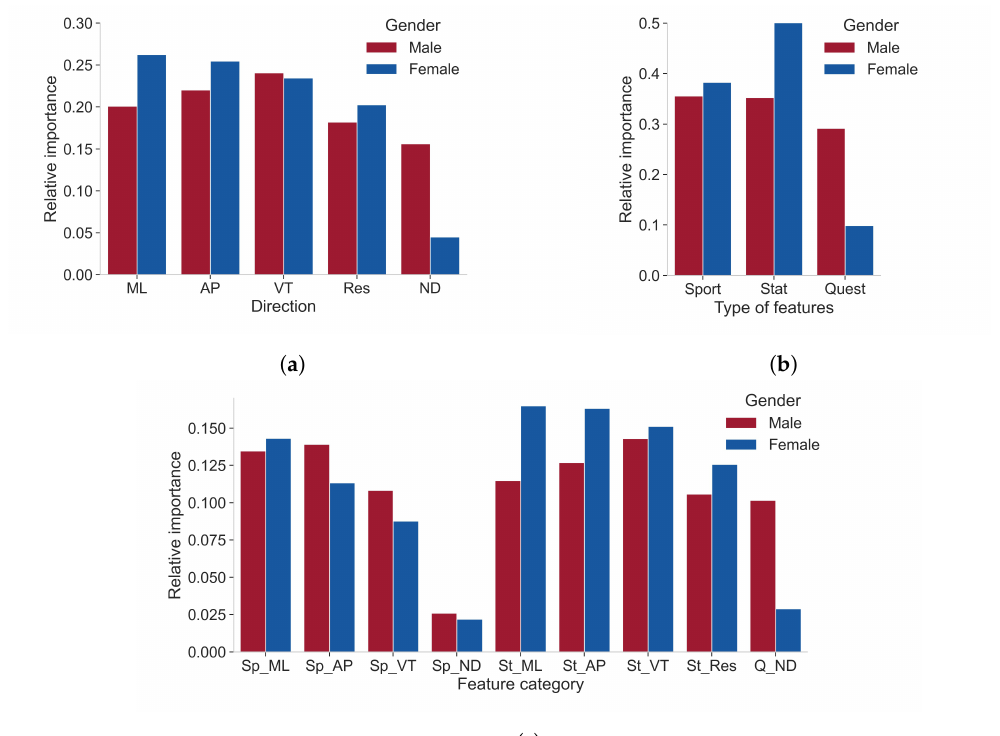
Figure 5. Relative average importance of several feature categories for the male- and female-specific logistic regression model. Two different criteria for subdividing the features into categories are considered: ( a ) directionality of feature, i.e., medial–lateral (ML), anterior–posterior (AP), vertical (VT), and resultant direction (Res), or non-directional (ND), ( b ) the type of feature, i.e., sports-specific (Sport), statistical (Stat), or questionnaire-based (Quest), and ( c ) both the type of feature (before underscore; Sports specific (Sp); Statistical (St); Questionnaire (Q)) and the directionality of the feature (after